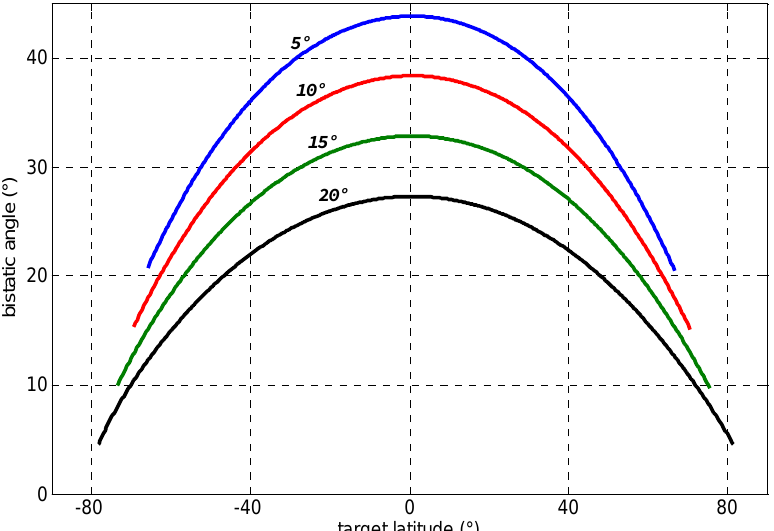
Figure 7. Bistatic angle for four bistatic antenna off-nadir angles within the range of covered